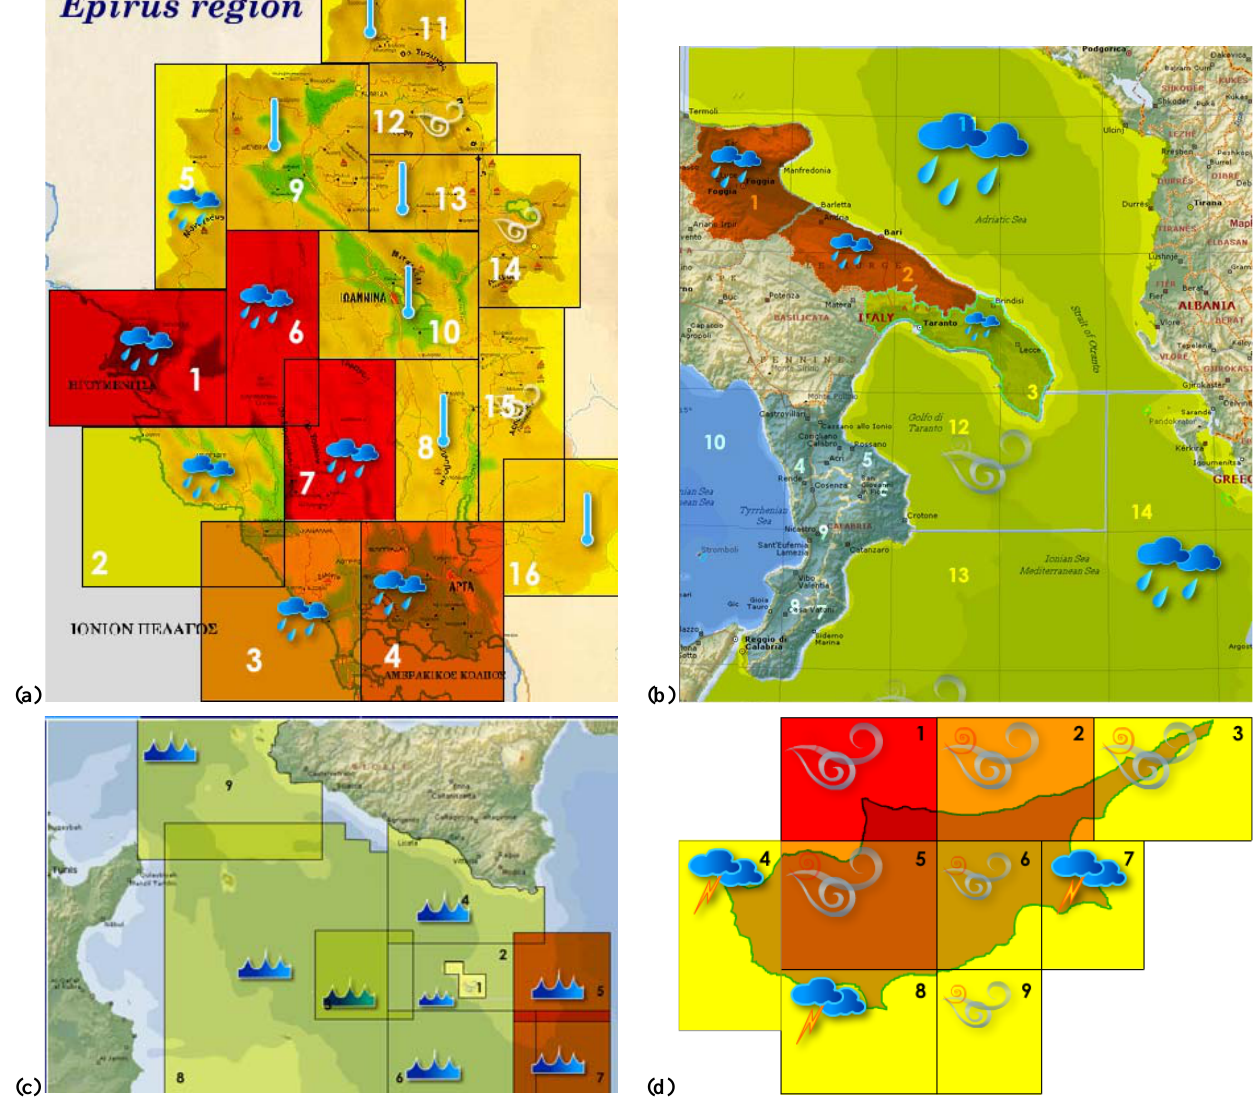
Fig. 3. Some winter examples of weather alerts for northwestern Greece (a) , southern Italy (b) , Malta (c) , and Cyprus (d)